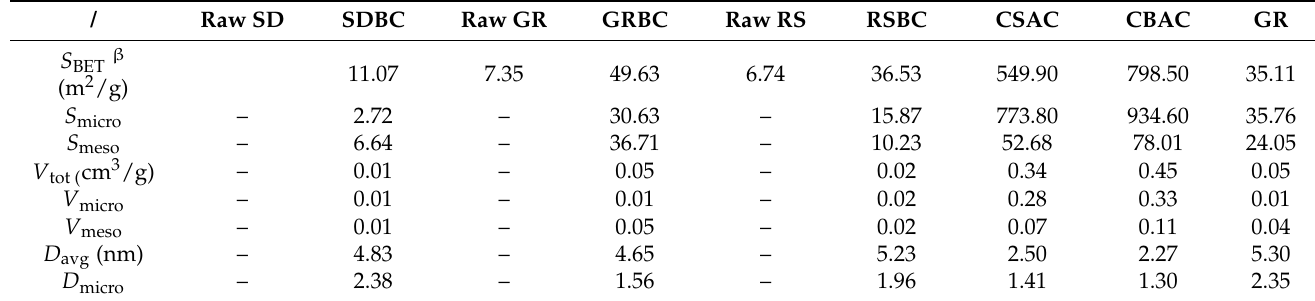
Table 2. Pore structure parameters of the adsorbents.